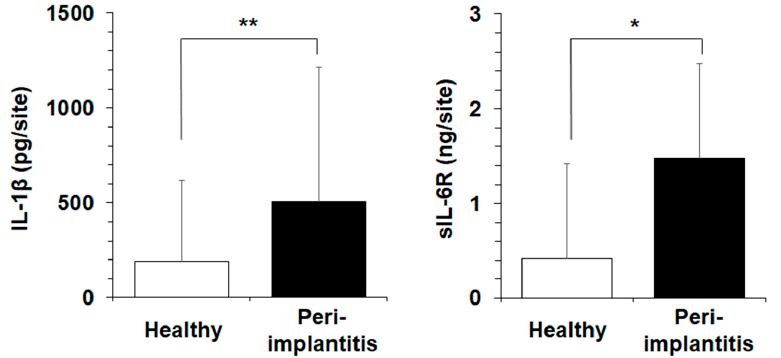
Figure 1. Inflammatory parameters in peri-implant crevicular fluid (PICF) of health and Peri-implantitis patients. Levels of interleukin (IL)-1 β and soluble interleukin (sIL)-6R in the collected PICF were measured using an enzyme-linked immunosorbent assay (ELISA) kit. Data are the mean ± SD. Values of * p < 0.05 and ** p < 0.01 were considered to indicate statistical significance (Mann-Whitney U test).